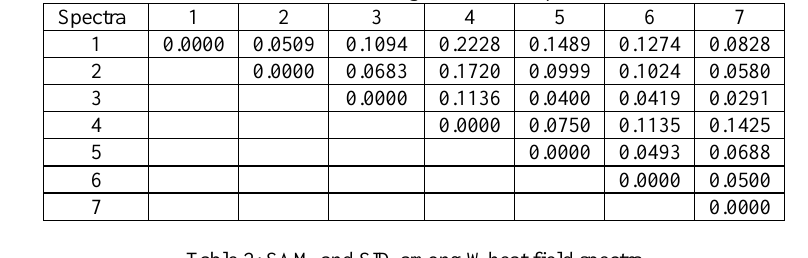
Table 1: CBD among Wheat field spectra